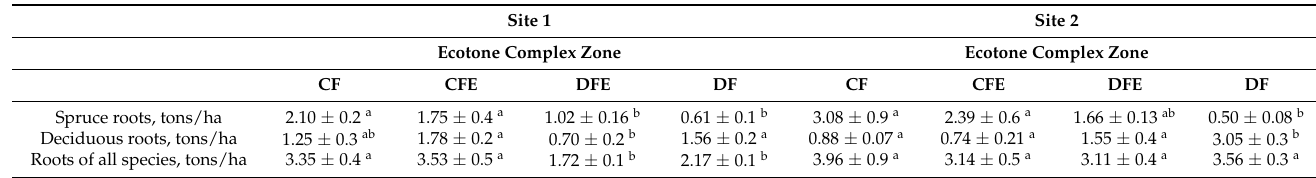
Table 5. Biomass of tree roots (diameter ≤ 2 mm) in the top 20 cm of soil. Site 1 Site 2 Ecotone Complex Zone Ecotone Complex